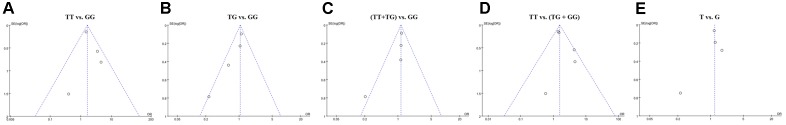
Funnel plot of the association of STAT4 rs7574865 polymorphism with the susceptibility of autoimmune thyroid disease. (A–E) Indicates homozygote comparison, heterozygote comparison, dominant model, recessive model, allele comparison, respectively.